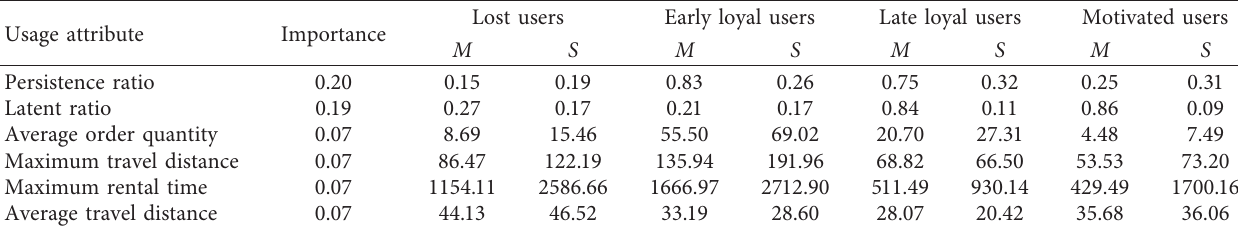
Table 6: Ranking of importance indexes of various users under the optimal model. Usage attribute